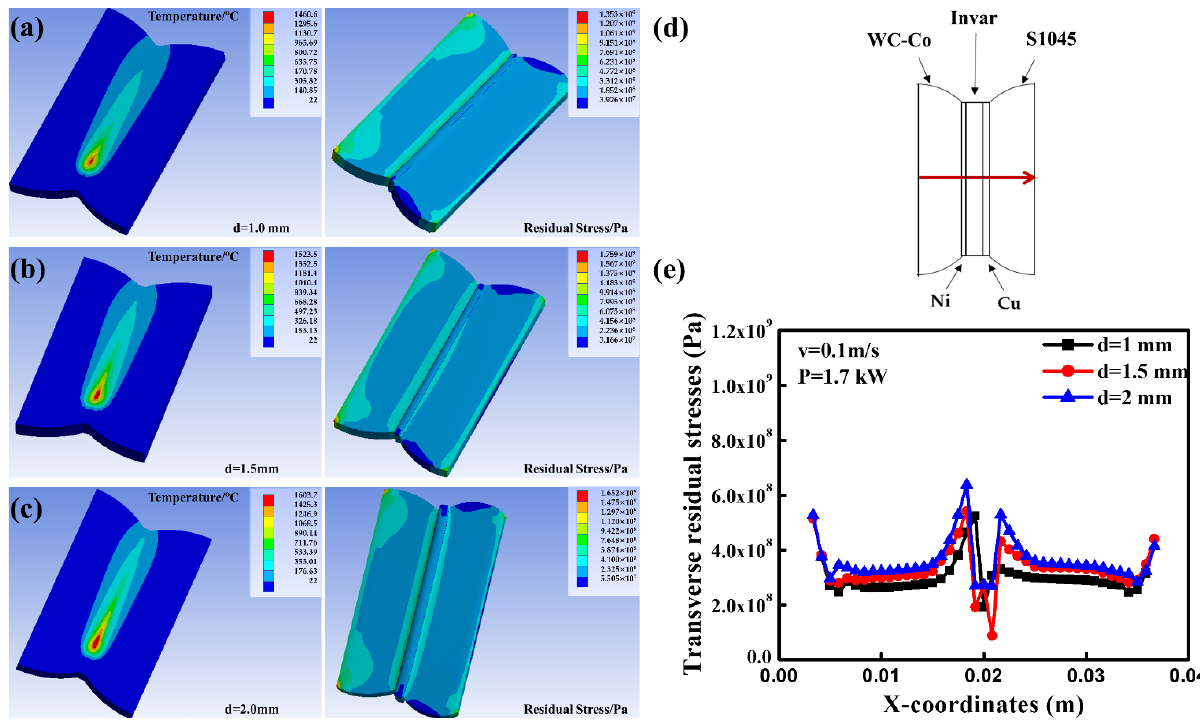
Figure 15. Simulation results of temperature field and residual stresses field when the thickness of Invar is equal to: ( a ) 1 mm, ( b ) 1.5 mm, ( c ) 2 mm, ( d ) Schematic diagram of residual stress simulation, ( e ) Comparison curve of residual stress at different thickness of Invar.